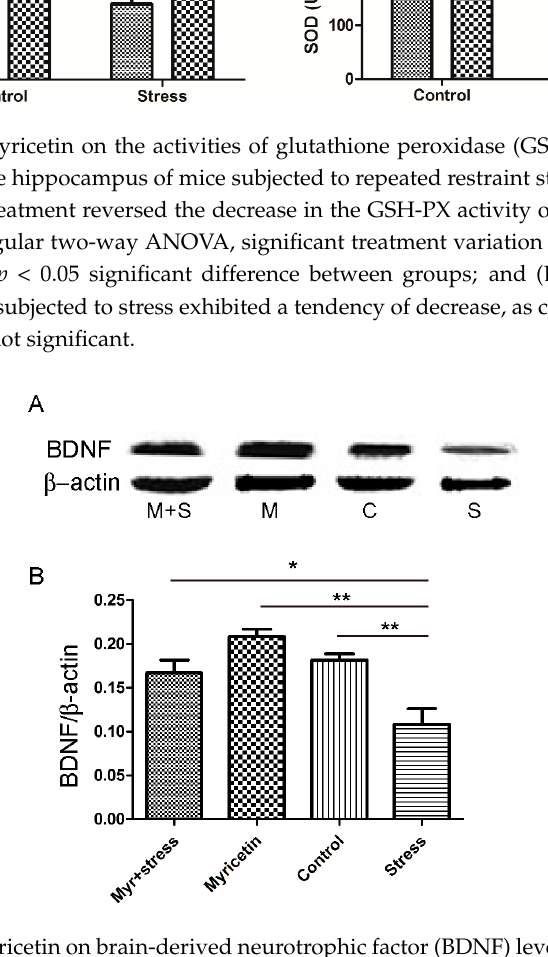
Figure 4. Effects of myricetin on brain-derived neurotrophic factor (BDNF) levels in the hippocampus of mice subjected to repeated restraint stress for 21 consecutive days. ( A ) The expressions of BDNF significantly decreased in the hippocampus of mice subjected to repeated restraint stress for 21 consecutive days. These effects were partially restored by myricetin administration. (M + S: Myricetin + repeated restraint stress; M: Myricetin; C: Control; S: repeated restraint stress); and ( B ) statistical analysis. Data were presented as the ratio of BDNF to β -actin. Each bar represented the mean ± SEM of three independent experiments. * p < 0.05, ** p < 0.01 respectively.